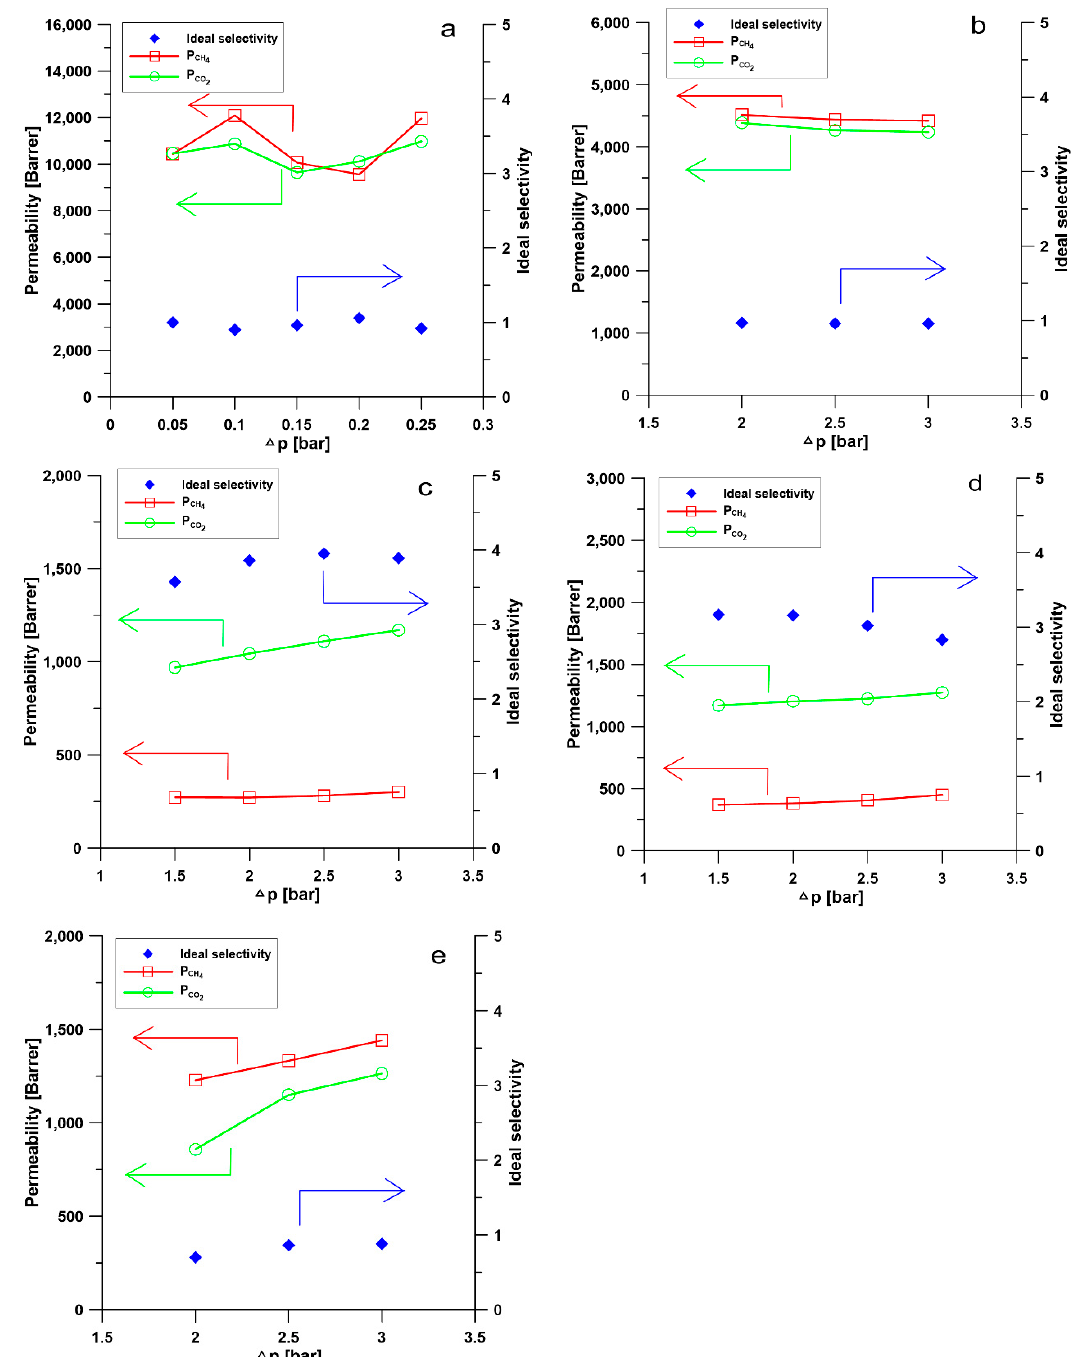
Figure 12. Permeability of CO 2 and CH 4 and CO 2 / CH 4 selectivity through PPSU based membranes in which ( a ) represents data for M1, ( b ) represents data for M2, ( c ) represents data for M3, ( d ) represents data for M4, and ( e ) represents data for M5